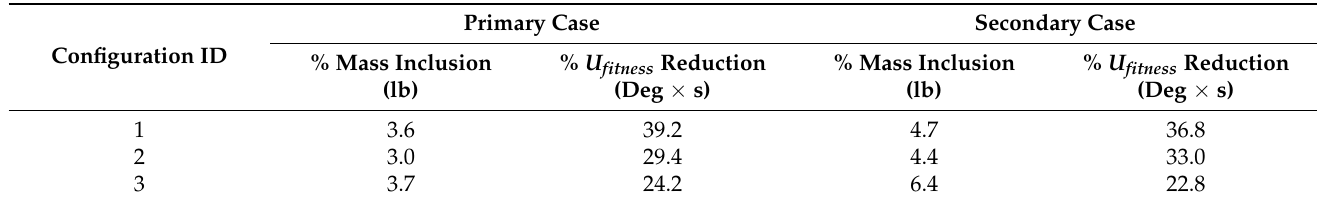
Figure 11. Comparison of the frequency response functions, for the Θ DOF, considering all the best individuals of each configuration investigated, obtained with the utopian point method. The ( a ) graph presents the results for the primary operational case modelled with the PSD, while the ( b ) graph represents the secondary operational case. Table 5. Pareto front values for the best individuals under the TDG gust excitation